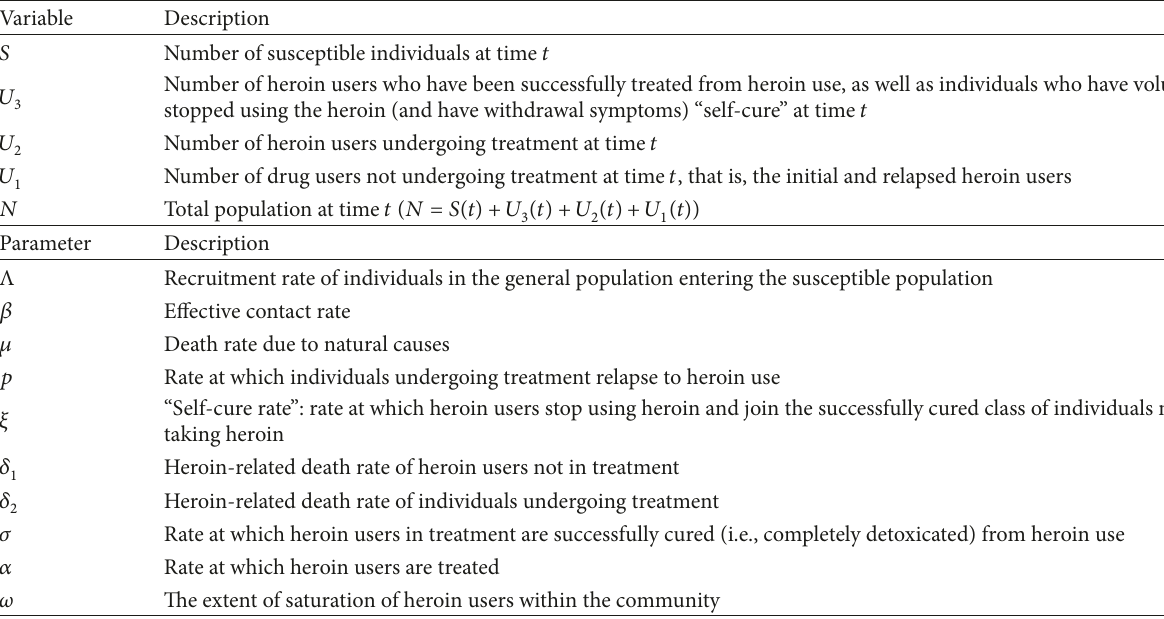
Table 1: Description of variables and parameters of model